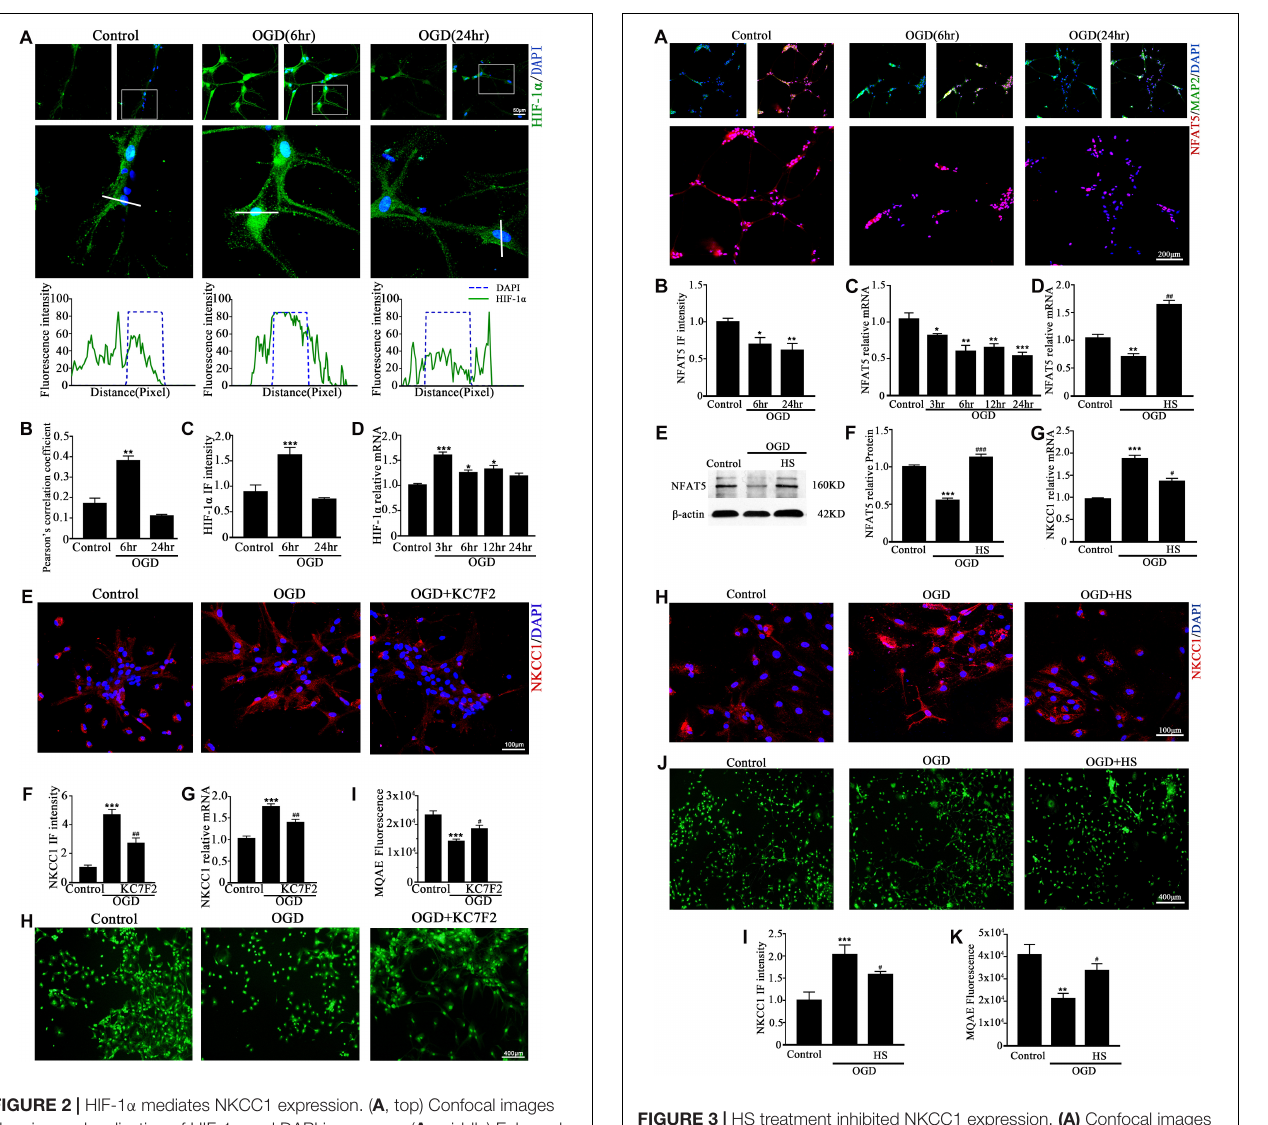
NKCC1 expression ( Figures 3G–I ) and neuronal [Cl − ] i ( Figures 3J,K ) after OGD. To further confirm the